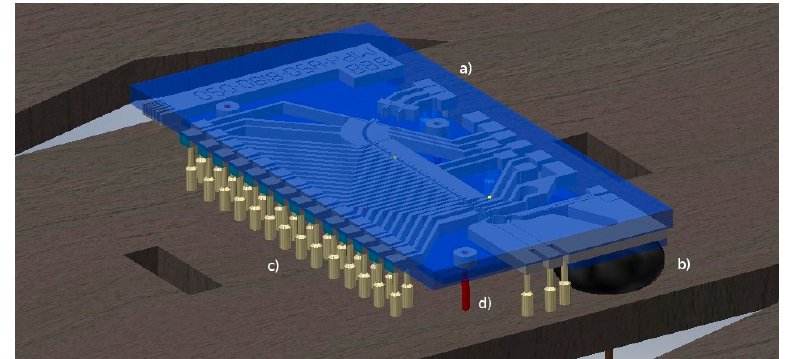
Figure 2. First concept of an exchangeable MEMS-chip ( a ) MEMS-Chip with a size of 13 mm × 7 mm and mass spectrometer structure; ( b ) Plasma gas channel is sealed with an O-ring; ( c ) spring-loaded pins for electric connections; ( d ) spring-loaded pins to ensure the positioning of MEMS-Chip.